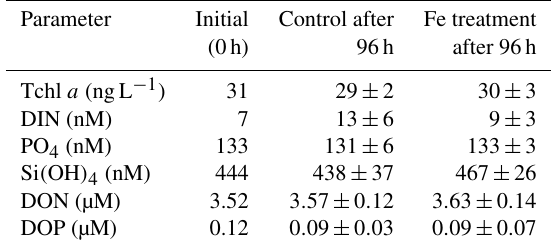
Table A1. Results of a Fe-enrichment incubation experiment at sta- tion 18 in the ESP. Errors represent standard deviations ( n = 3). Differences between mean values in control and Fe treatment were insignificant for all parameters ( t test, p > 0 .